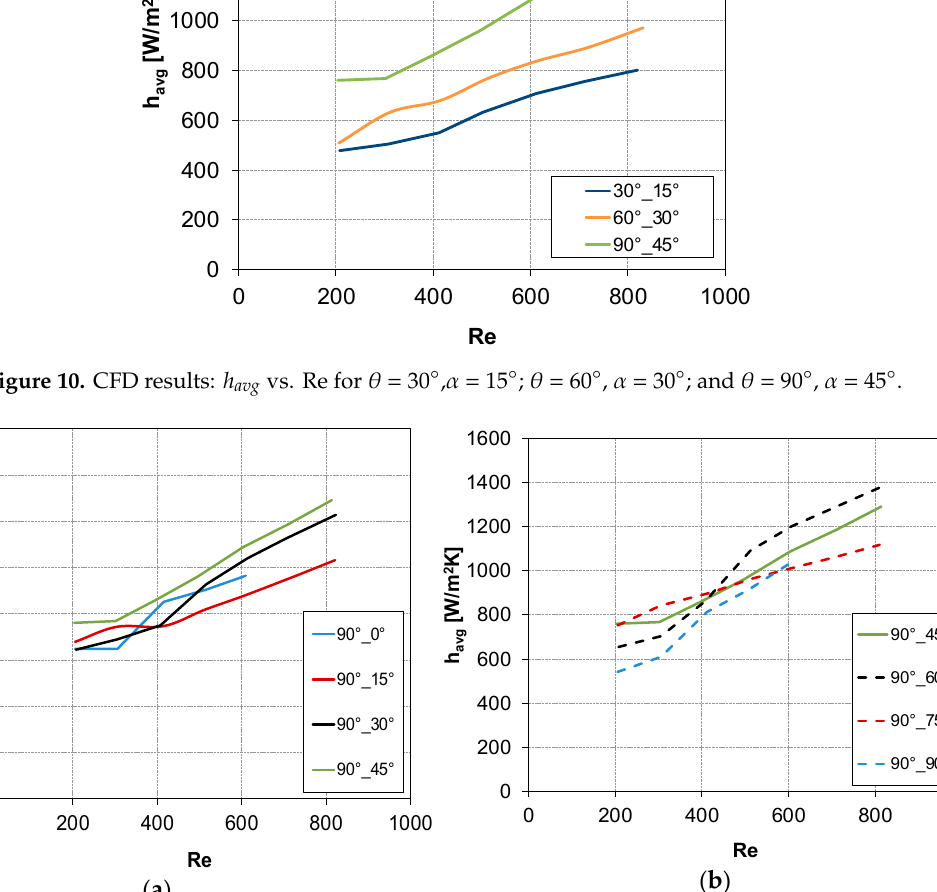
Figure 11. CFD results: h avg vs Re for θ = 90°: ( a ) α ≤ 45° and ( b ) α ≥ 45°.